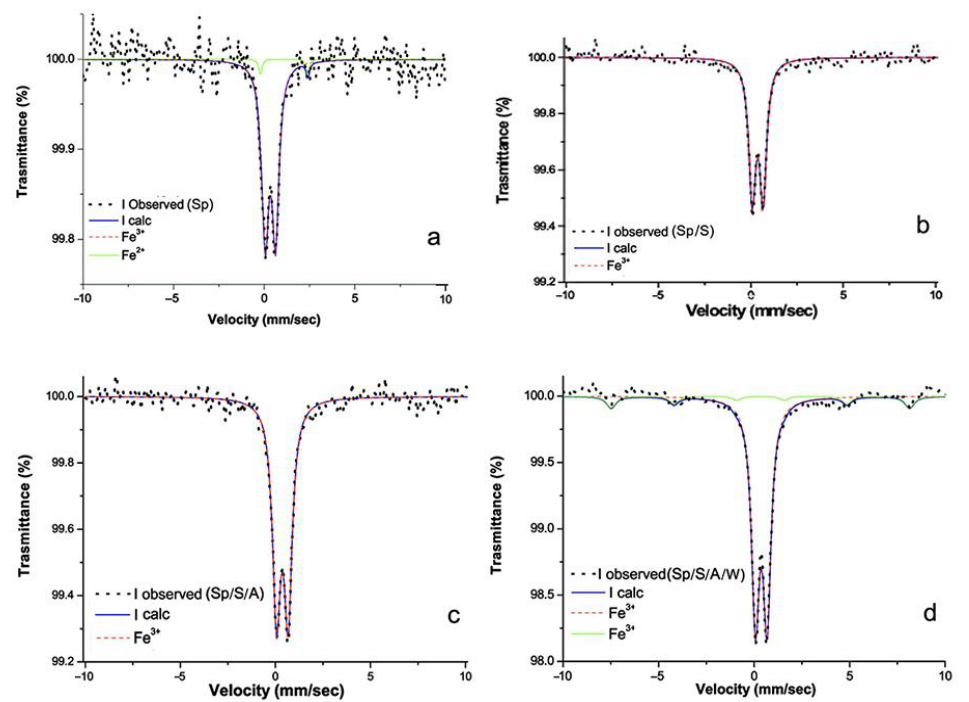
Figure 7. Mössbauer spectra of marble samples artificially stained outdoors during: ( a ) one season (spring, Sp); ( b ) two seasons (spring and summer, Sp/S); ( c ) three seasons (spring, summer, autumn, Sp/S/A); and ( d ) four seasons (spring, summer, autumn, winter, Sp/S/A/W). Observed absorption intensity (I obs, black dots) and calculated total intensity (I calc, continuous blue line) are plotted together with calculated absorption components (dashed red line for the Fe 3+ central doublet, continuous green line for accessory components) .